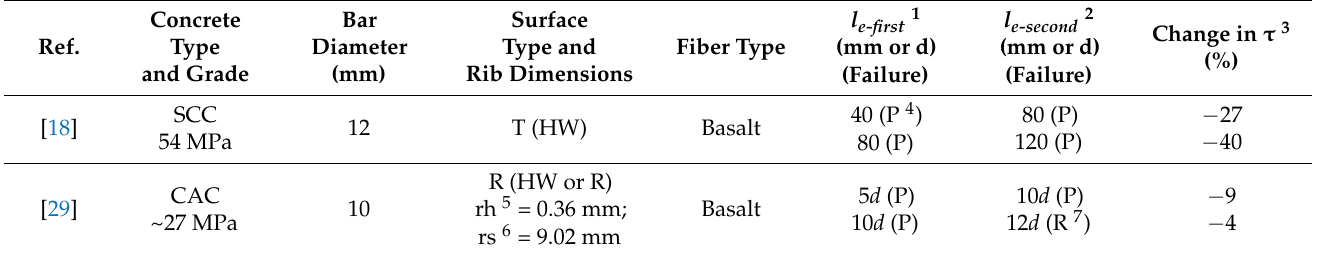
Figure 7. Effect of embedment length on bond strength [38].